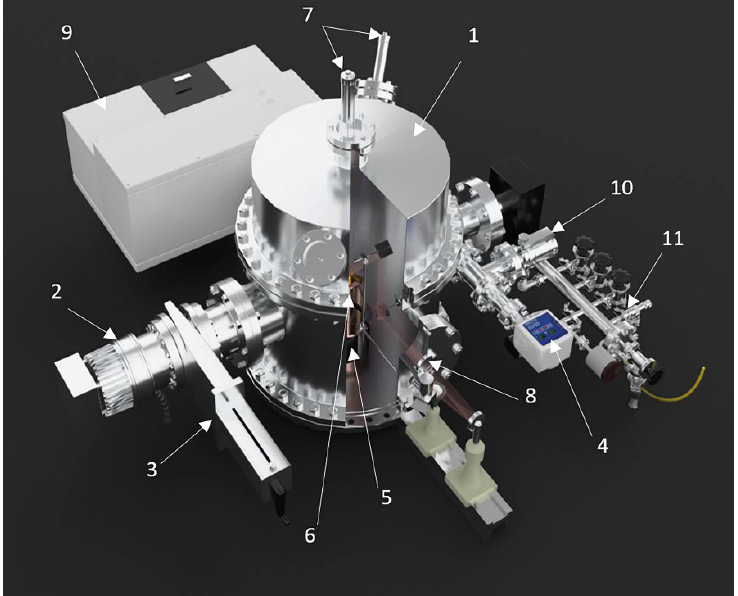
Figure 3. Experimental setup for cryovacuum condensation: 1: vacuum chamber, 2: vacuum pump Turbo-V-301, 3: vacuum gate valve CFF-100, 4: pressure detector FRG-700, 5: Gifford–McMahon refrigerator, 6: substrate, 7: photo multiplier, laser interferometer, 8: light source, optical channel, 9: IR-spectrometer, 10: high-precision gas supply leak into the chamber; 11: gas leak into the mixture production system.